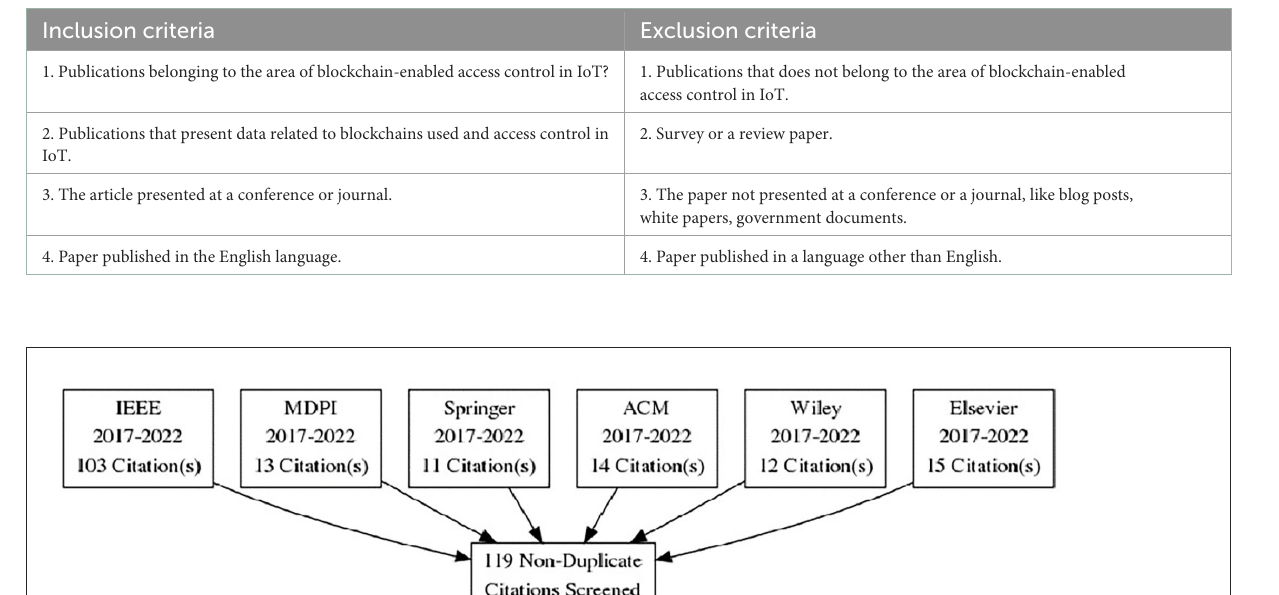
TABLE 2 Inclusion–exclusion criteria.